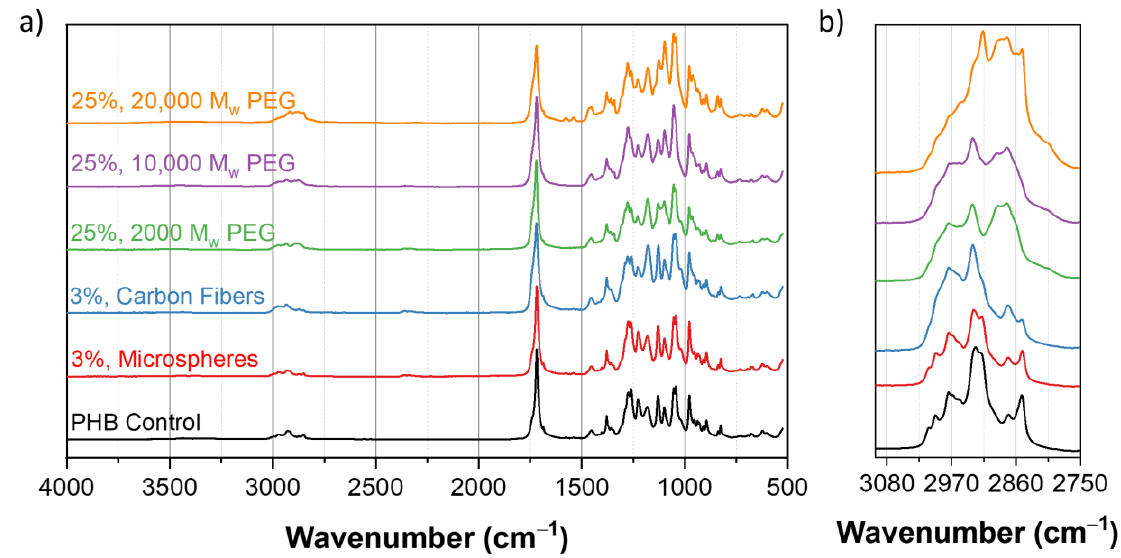
Figure 7. ( a ) IR spectra of PHB composites in the 500 to 4000 cm − 1 frequency range. Absorption bands at 1280 and 1720 cm − 1 are representative of the PHB content. ( b ) IR spectra in the 2750 to 3100 cm − 1 range, for emphasizing on the effects of the PEG content at the 2930 cm − 1 peak.